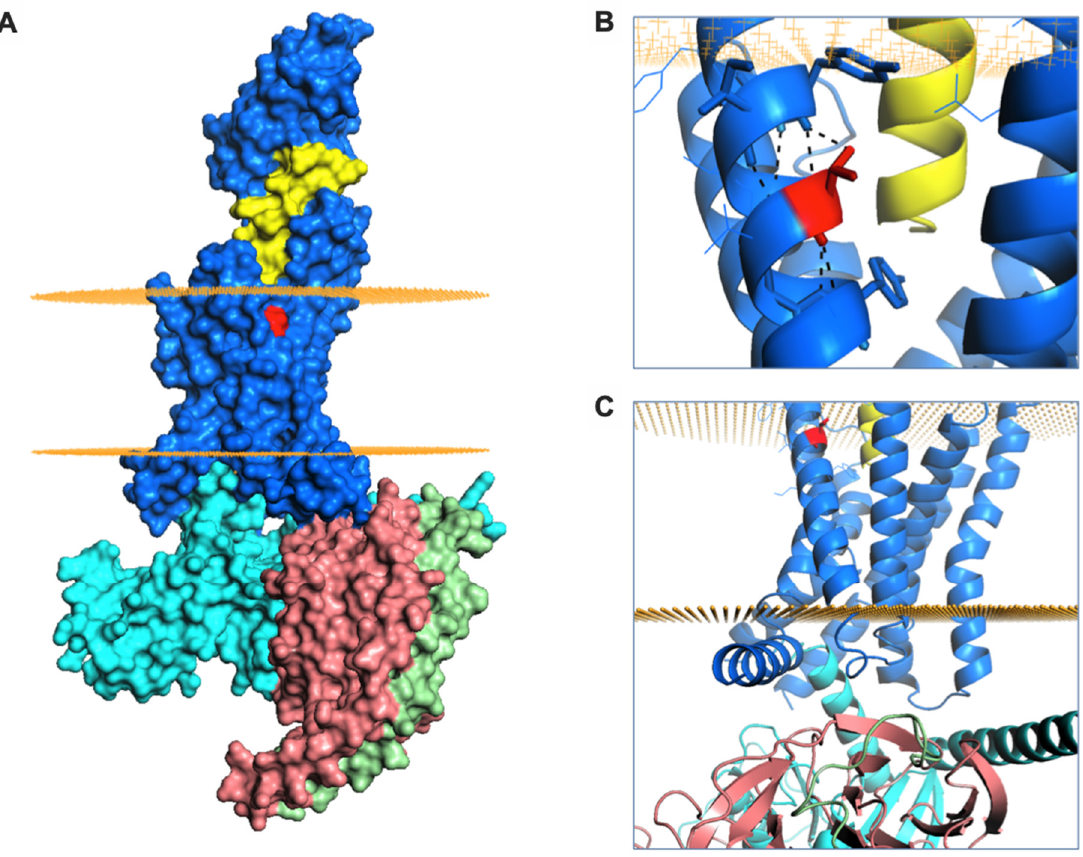
Figure 5. GLP-1R structure and T149 structural role. ( A ) Surface representation of GLP-1R (in blue) bound to exendin-P5 (in yellow) and guanine nucleotide-binding protein G s subunit α (in cyan), β (in salmon) and γ (in green). The intracellular and extracellular boundaries of the lipid bilayer are presented as orange disks. T149 is coloured in red. ( B ) The intrahelical hydrogen bond formed by T149 (in red) is highlighted with black dashes. ( C ) Cartoon representation of GLP-1R structure highlighting the juxta-membrane and intracellular region of TM1. The G protein subunits are also shown.